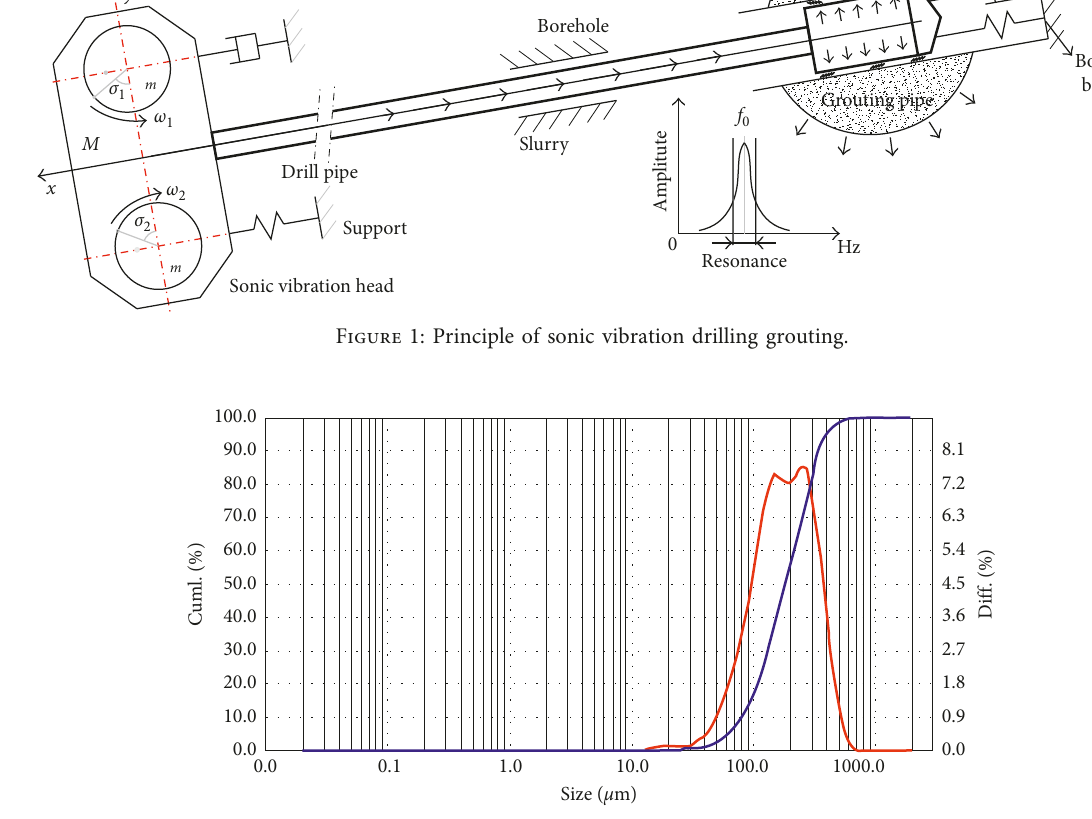
Figure 2: Distribution of particle diameter. Table 1: Physical property indexes of the test sand.